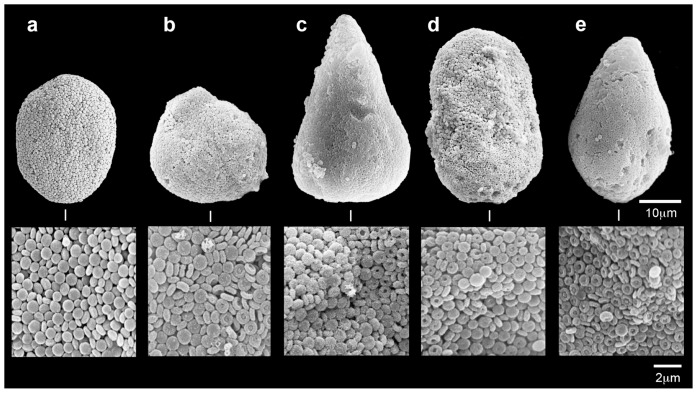

Ovabunda macrospiculata: Visual score of sclerite damagea. Rank 0, 0% damage, b. Rank 1, 1–20% damage, c. Rank 2, 21–40% damage, d. Rank 3, 41–60% damage, e. Rank 4, >60% damage.